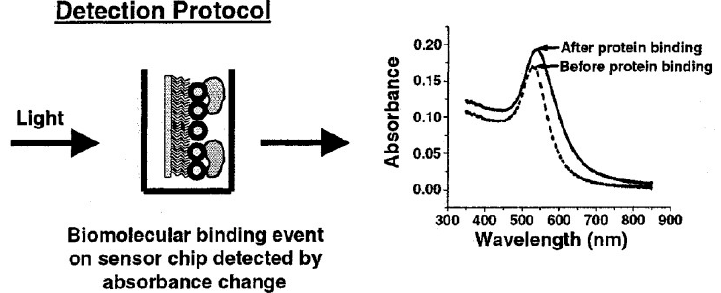
Figure 4. The detection protocol of a LSPR sensor. Here the LSPR sensor is a layer of gold nanoparticles immobilized by self-assemble silane monolayer on the glass substrate. Metal nanostructures other than nanoparticles can work in a similar manner. The binding of analytes on a LSPR sensor results in a shift of the absorption spectrum as well as an increase in peak amplitude. Reprinted with permission from [39]. Copyright 2002 American Chemical Society.